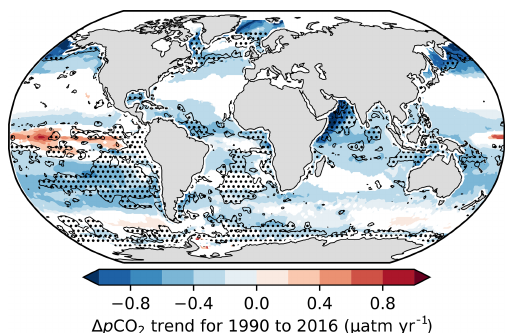
Figure 13. (cid:49)p CO 2 trends ( p < 0 . 05), where (cid:49)p CO 2 is calculated as the estimated surface ocean p CO 2 from the CSIR-ML6 method minus atmospheric p CO 2 from the CarboScope project (Rödenbeck et al., 2014). The shaded areas show the regions where IQR IA is > 15%, thus indicating regions where trends should be interpreted with